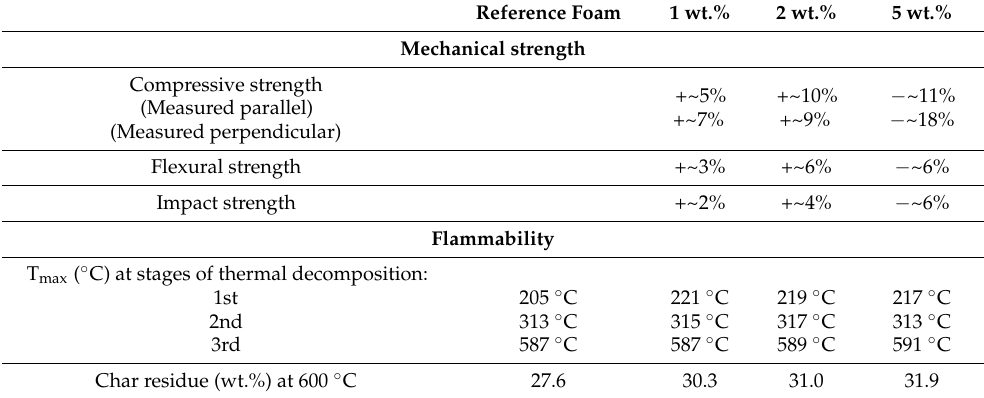
Table 4. Value comparison of reference foam, 1, 2 and 5 wt.%